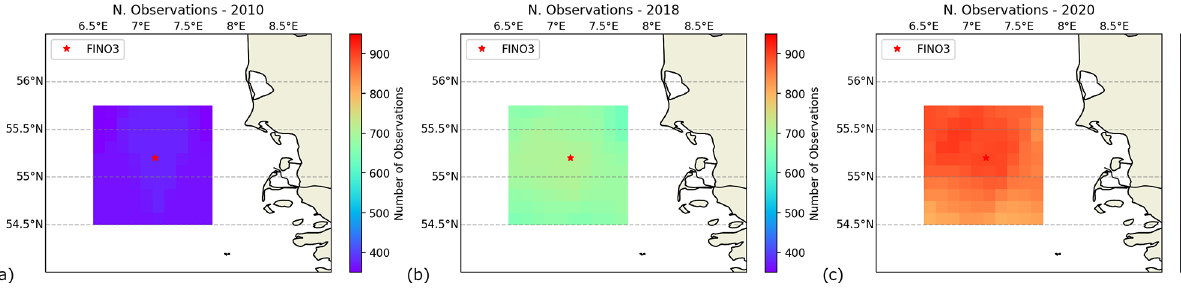
Figure 7. Cumulative samples of ASCAT observations at each WVC of the study area for (a) 2010, (b) 2018 and (c) 2020.